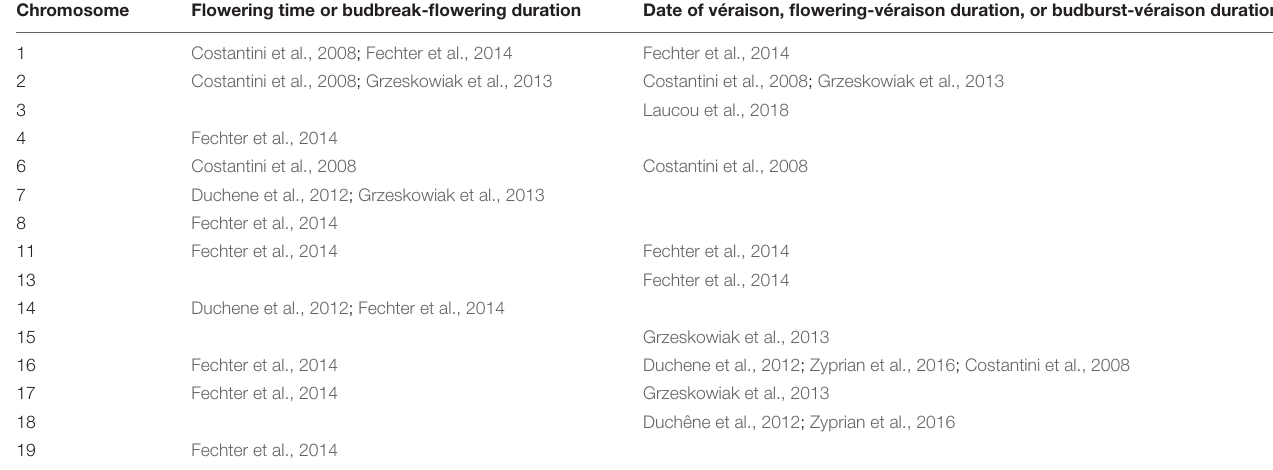
TABLE 1 | Main QTLs for developmental stages.